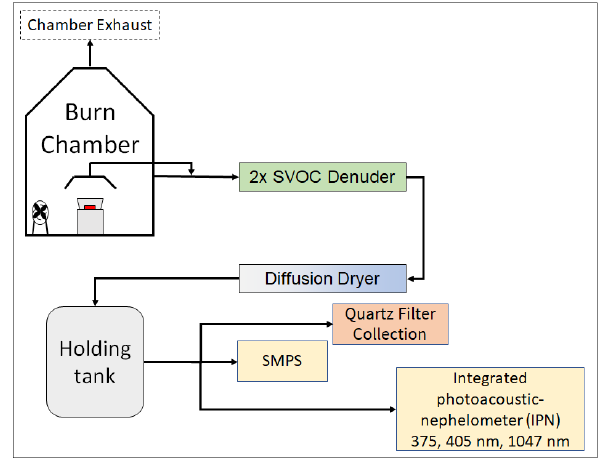
Figure 1. A schematic representing the experimental setup. The aerosol emissions were sampled either directly from the chamber wall or through a hood placed above the combusting